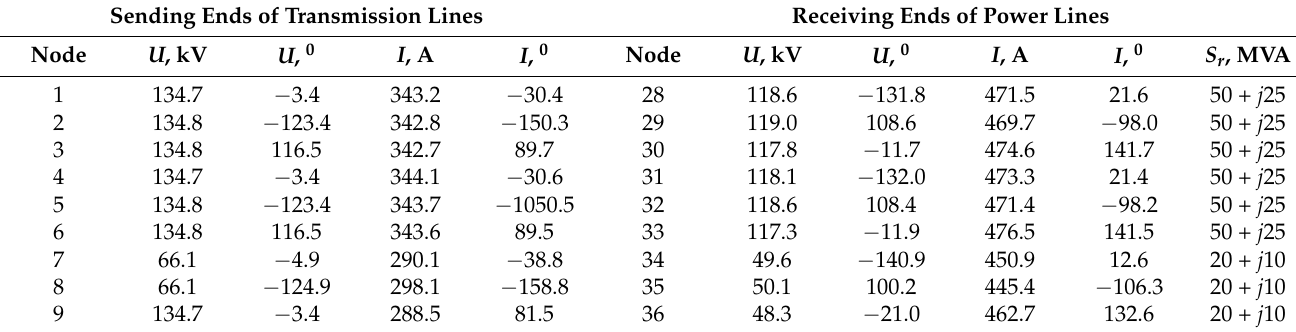
Table 1. Calculation results for a three-circuit transmission line.